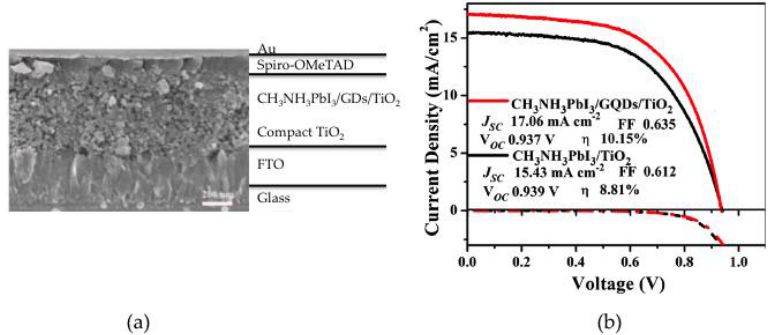
Figure 7. ( a ) Cross-sectional view of the SEM image; ( b ) JV curve of the devices comparing the effect of the insertion of the GDs. Reproduced with permission of [38].